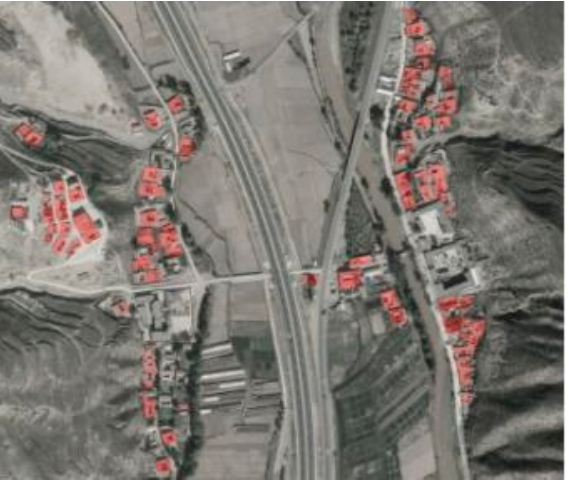
Figure 1. Map of the percentage of local rammed earth buildings (source: Google map).